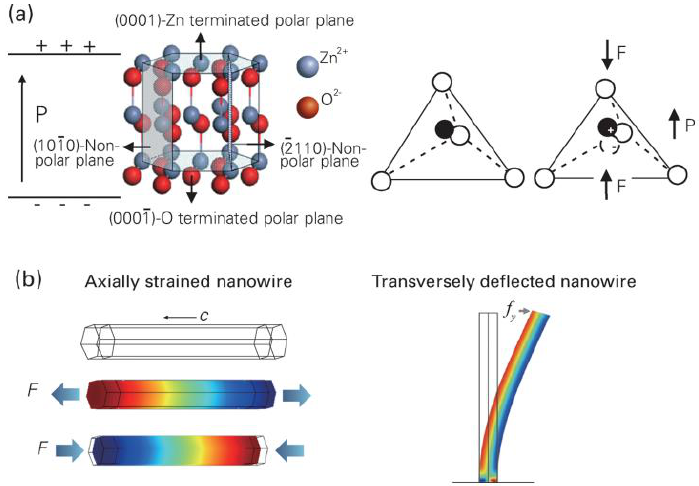
Figure 3. ( a ) Atomic model of the wurtzite − structured ZnO. ( b ) Finite element analysis simulated piezoelectric potential distribution in a ZnO nanowire. Three − dimensional graphs of the nanowire piezoelectric potential distribution and deformation shape at 85 nN of stretching force (middle) and 85 nN of compressing force (bottom). Reproduced with permission [30]. Copyright 2018, IOP